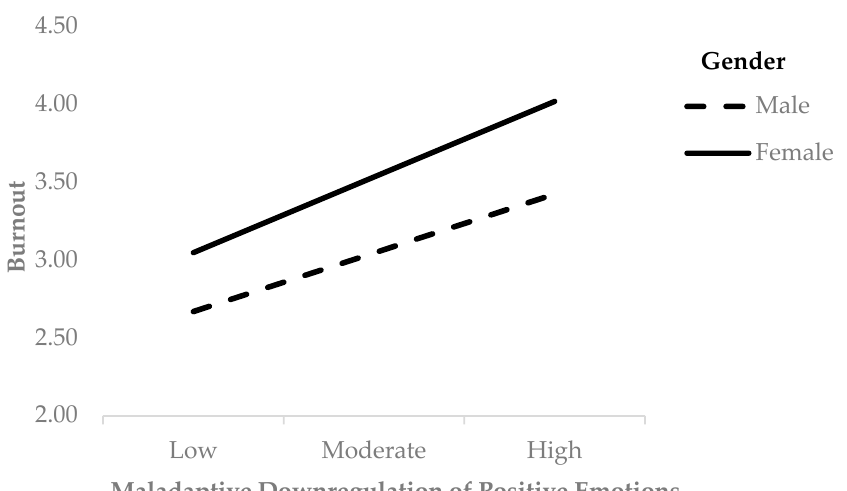
Figure 4. Cognitive reappraisal predicting physical illness as a function of gender.